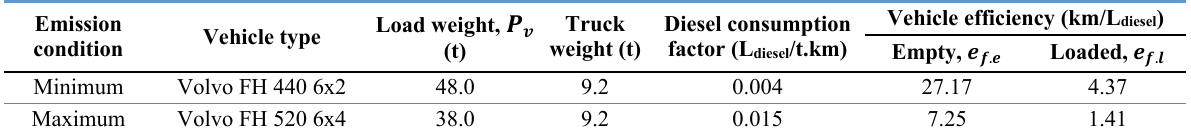
Table 4. Load weight and efficiency of